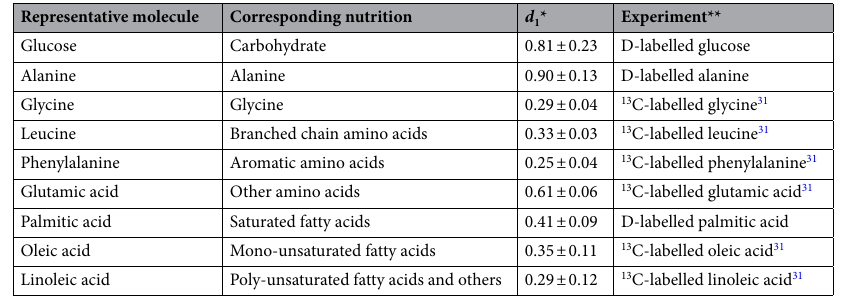
Table 9. Representative molecules for each nutrient. *Ratio of organic compounds to inorganic compounds immediately after administration. **Isotope administration experiments to determine the value of d 1 . Values of d 1 are mean ± standard